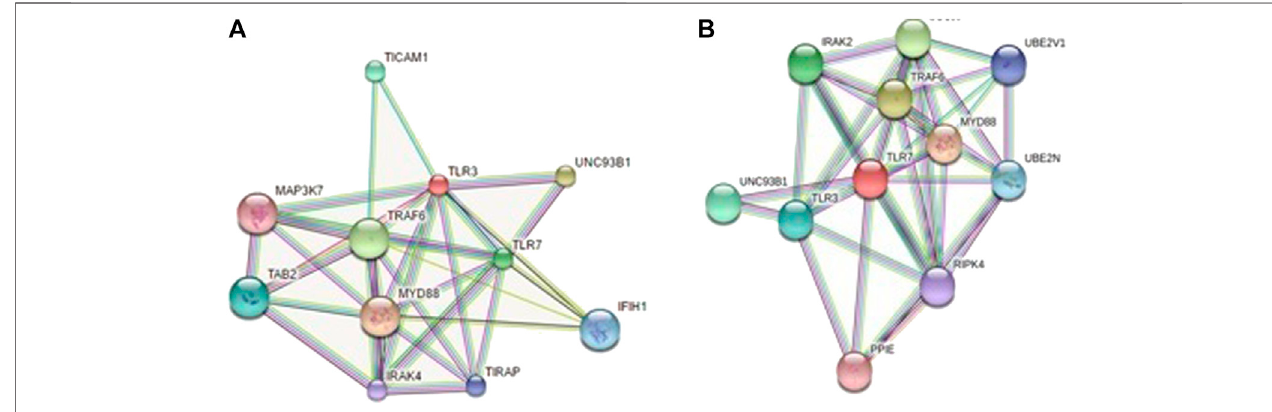
FIGURE 10 | (A) String analysis revealing molecular interaction of TLR3 (B) String analysis revealing molecular interaction of